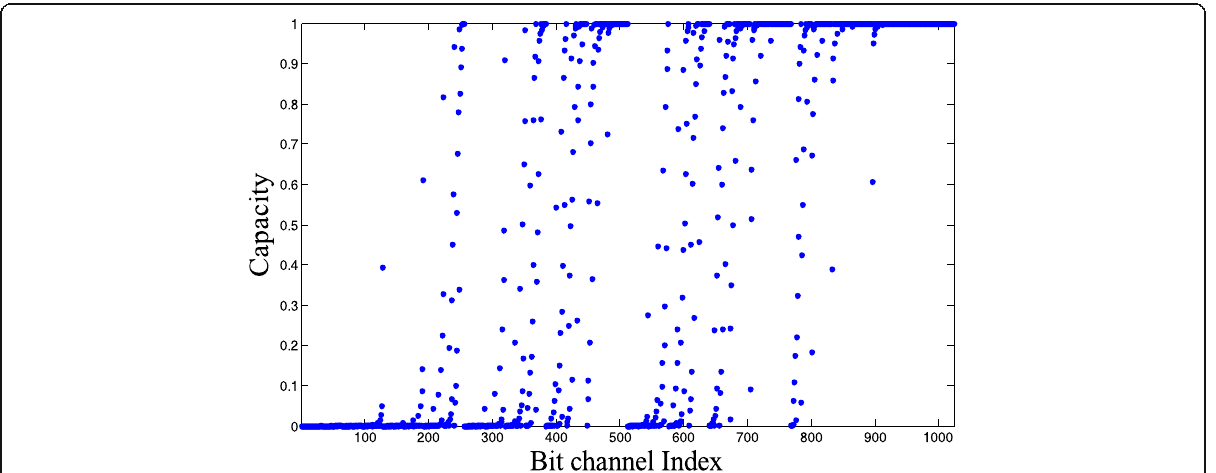
Fig. 5 The capacity of bit channel at N = 1024: The capacity of binary erasure channels (BEC) when the code length N is 1024